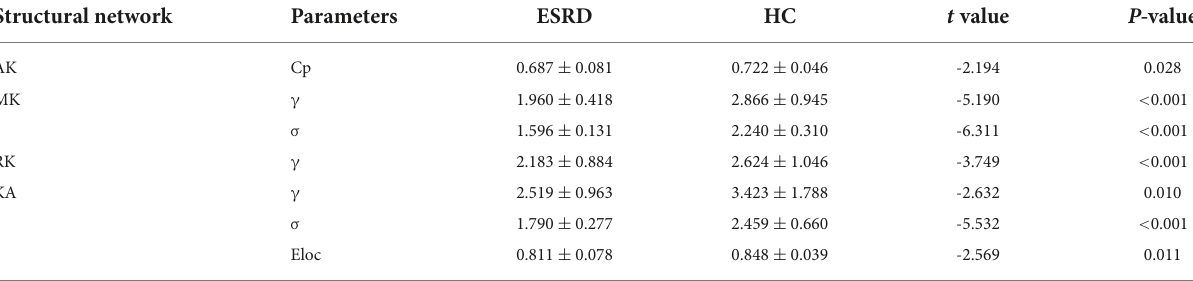
TABLE 2 Significant between-group differences of topological parameters of gray matter (GM) network. Structural network